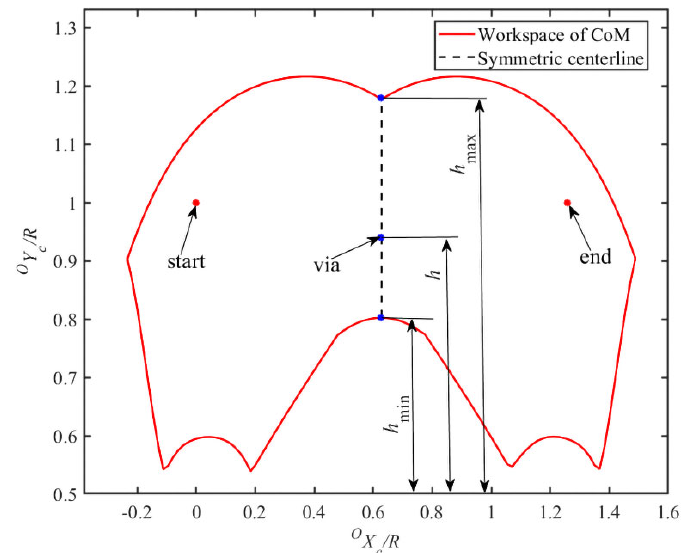
( b ) Figure 6. the workspace of the mechanism’s CoM at the initial and end positions. (a) 𝜙 (cid:3404) 0 . (b) 𝜙 (cid:3404) 2 𝜋 /5 . In order to avoid spontaneous rolling, the CoM of the mechanism and the grounded point P should be in the same vertical line at the initial position, while they also should be in the same vertical line to achieve periodic locomotion at the end position. Therefore, the coordinates of the CoM at the initial and end positions can be written as